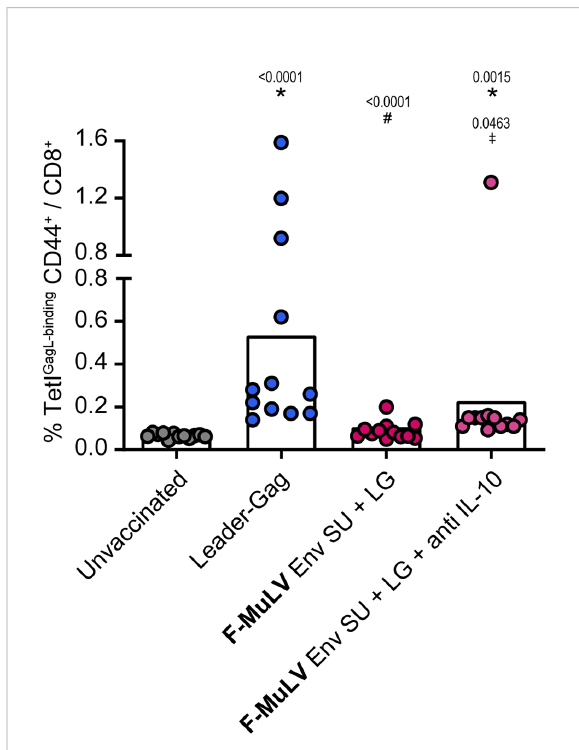
FIGURE 7 Inhibition of Leader-Gag-speci fi c CD8 + T-cell response by F- MuLV Env SU is partially alleviated by anti-IL-10 antibody treatment. CB6F1 mice were immunized twice in a 3-week interval with 25 µg of pCG.Leader-Gag with or without co- immunization with 25 µg of a plasmid encoding F-MuLV Env SU by intramuscular injection followed by in-vivo electroporation. One group of mice received an anti-IL-10 treatment three times per week starting on the day of fi rst immunization. Two weeks after the boost immunization, the frequency of GagL 85-93 - speci fi c CD8 + T cells was analyzed in peripheral blood. Data from 12 mice per group were acquired in two independent experiments. Each dot indicates an individual mouse, and bars indicate mean values. Statistically signi fi cant differences compared with the unvaccinated group are indicated by *, differences compared with the Leader-Gag group are indicated by # and differences to the F-MuLV Env SU + LG group are indicated by ‡ ( p < 0.05, Kruskal – Wallis one-way ANOVA on ranks, Dunn ’ s